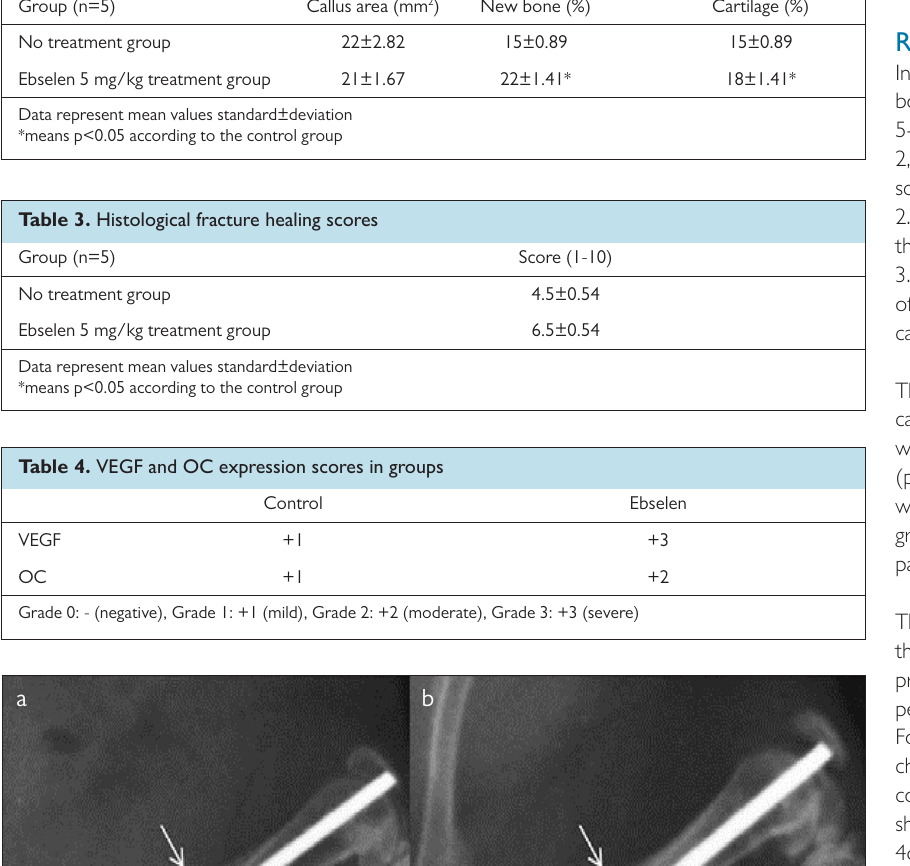
Table 2. Histomorphometric analysis measurements Group (n=5)